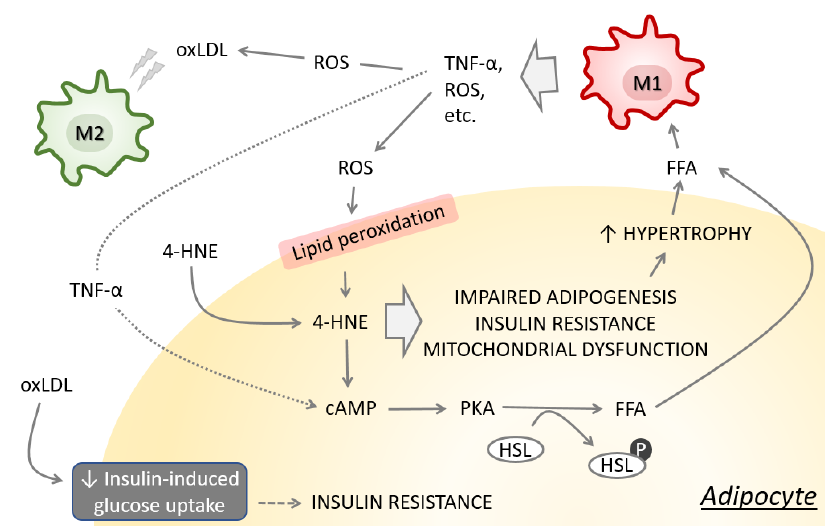
Figure 2. Altered redox homeostasis induces lipid peroxidation and promotes impaired adipogenesis, insulin resistance and mitochondrial dysfunction in adipocytes. These events consequently promote lipolysis and release of lipotoxic free fatty acids (FFA), promoting the TNF ‐α and ROS production by macrophages.